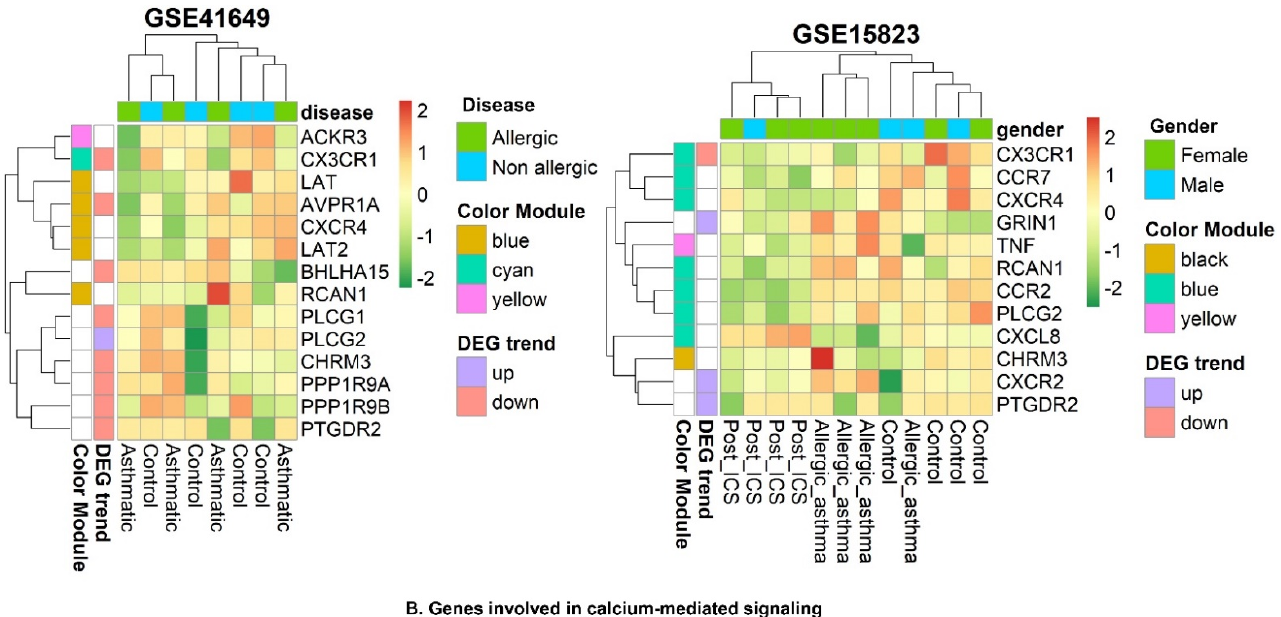
Figure 10. Identifying pathways for calcium regulatory genes involved in smooth muscle contraction. ( A ) GO biological process involved in smooth muscle contraction. ( B ) Regulatory genes involved in the calcium–mediated signaling pathway.